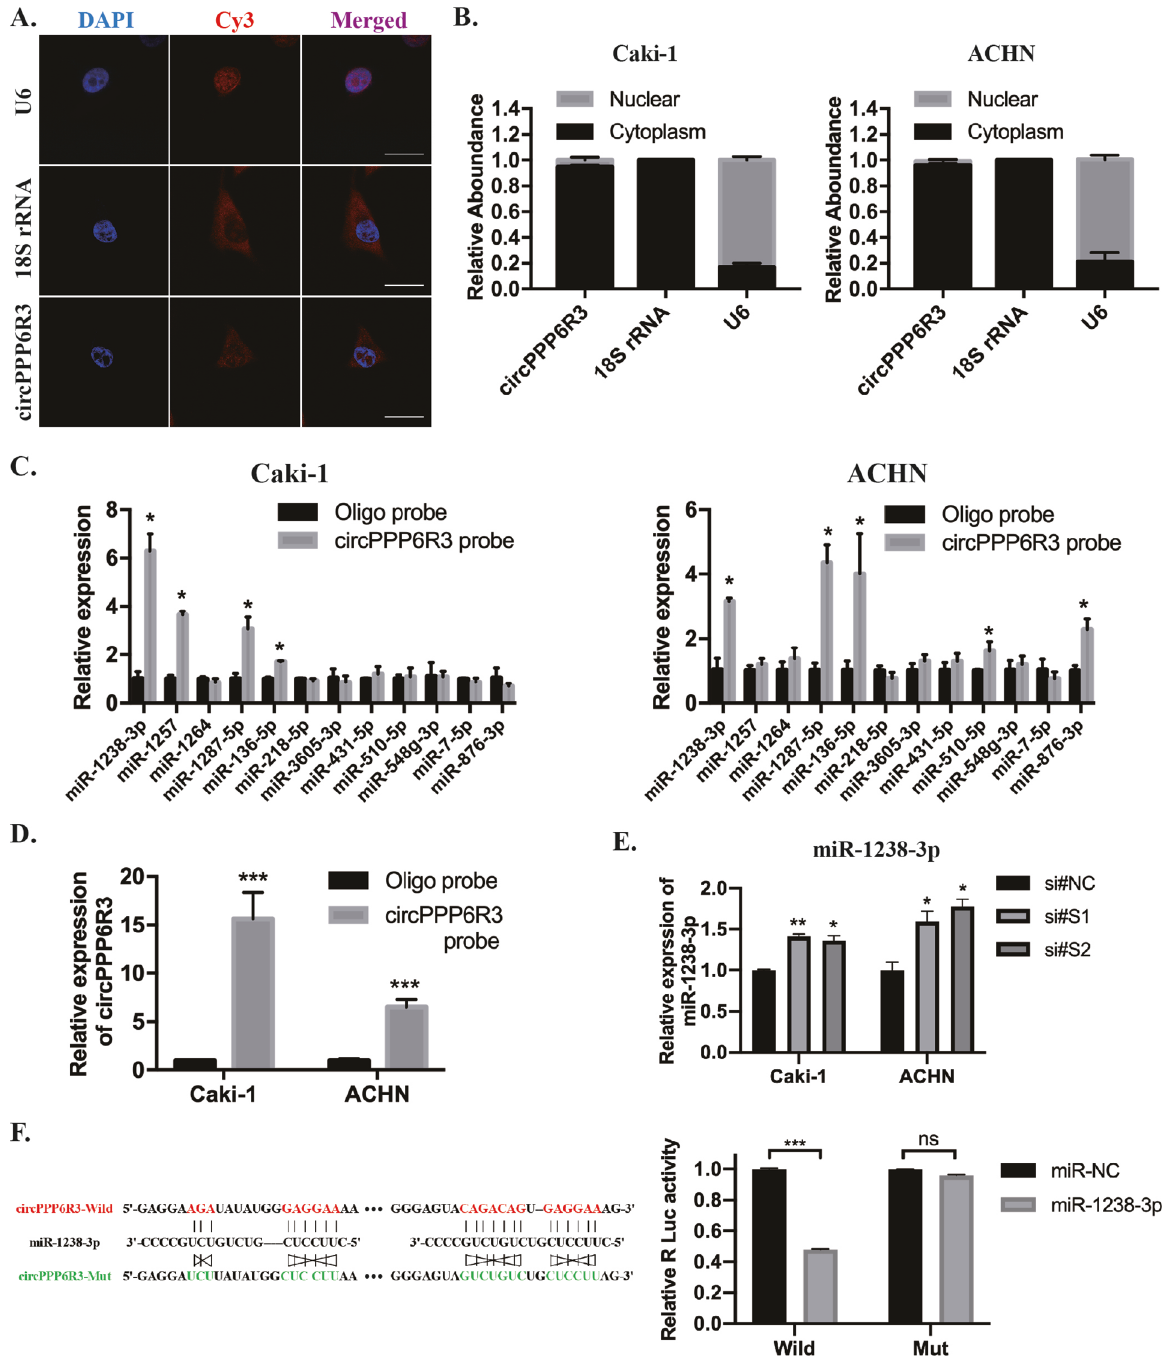
cytoplasmic and nuclear fractions was validated by qRT-PCR analysis. C The miRNAs predicted as the targets of circPPP6R3 were analyzed by qRT-PCR in the biotin-labeled circRNA probe pull-down assay. D The biotin-labeled circPPP6R3 probe could capture more circPPP6R3. E miR- 1238-3p in circPPP6R3-knockdown ccRCC cells was detected by qRT-PCR analysis. F Schematic illustration of circPPP6R3 wild type and circPPP6R3 mutant type dual-luciferase reporter vectors, and dual-luciferase reporter assay was performed in the 293T cells to determine the direct binding relationship between circPPP6R3 and